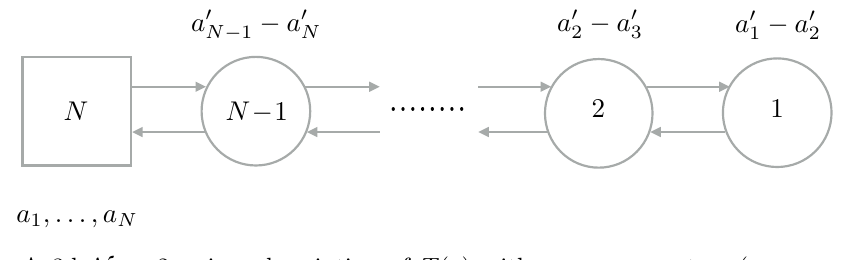
= 2 quiver description of T ( g ) with mass parameters ( a 1 ; : : : ; a N ) and FI N (cid:0) (cid:1) a 0 a 0 ; : : : ; a 0 a 0 1 (cid:0) 2 N 1 (cid:0) N (cid:0)